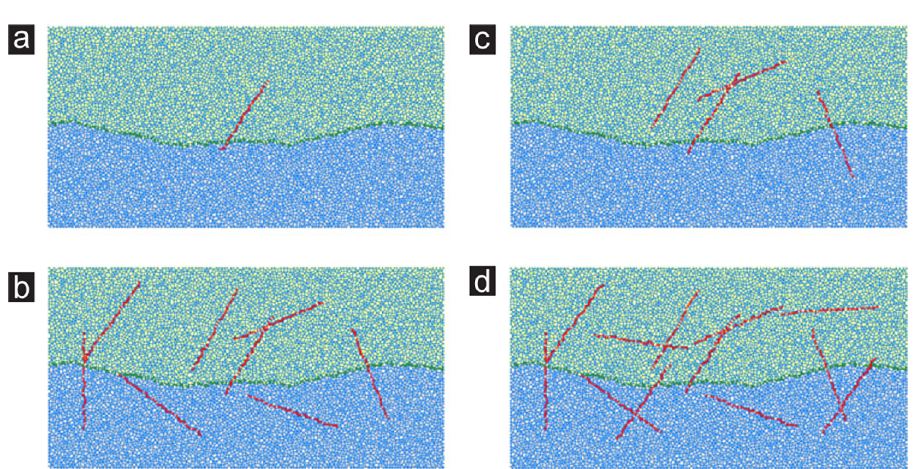
Fig 3. Diagram of stochastic joint network model of rock: (a) γ = 1, (b) γ = 4, (c) γ = 8, (d) γ = 12.